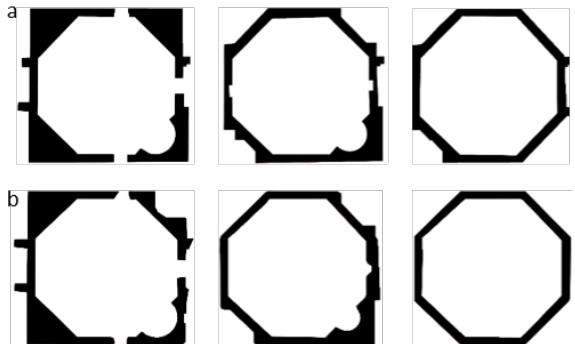
Figure 9. Sections at three different heights, from left: 0.5 m, 5.5 m, 10.0 m of the geometrical model (a) and the numerical model (b)